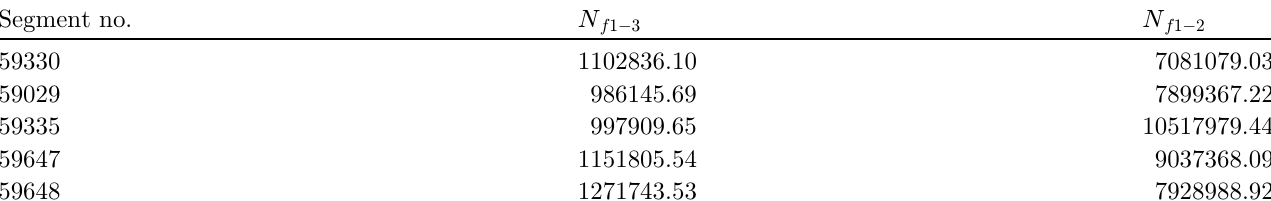
Table 7. Prediction of the fatigue life of shaft seal rings. Segment no.